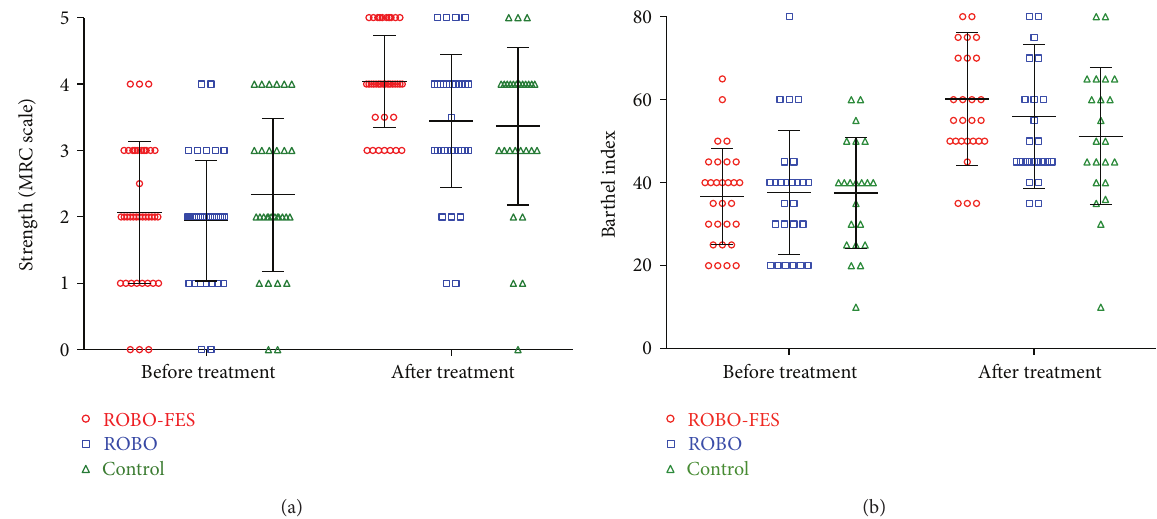
Figure 2: Participant flow through the study protocol.